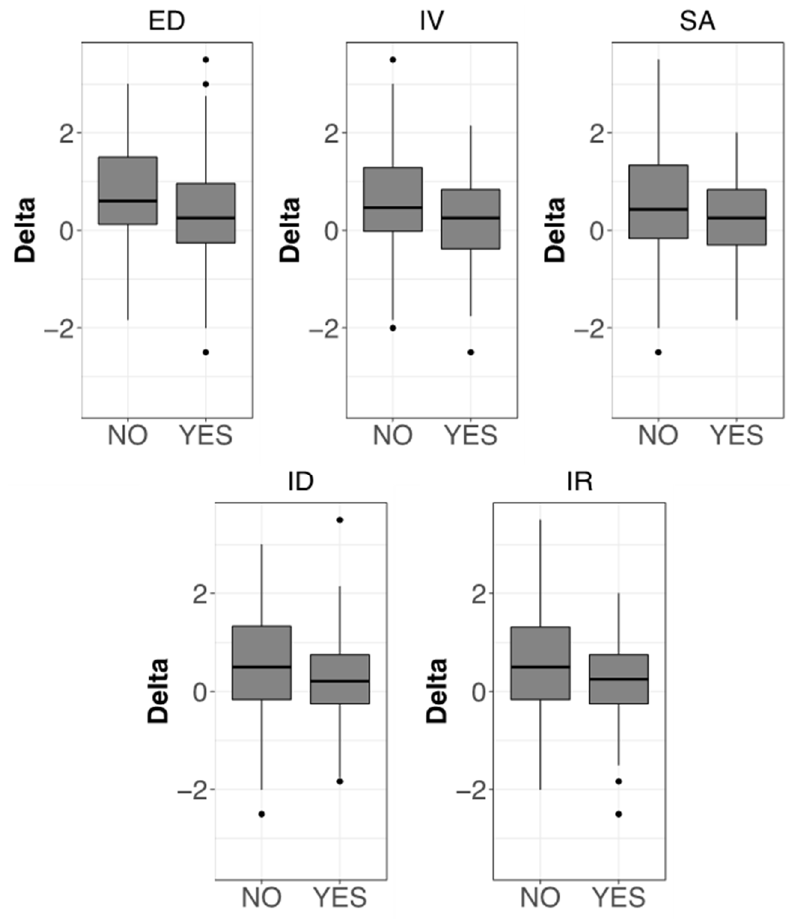
Figure 9. Boxplots showing the correlation between therapy effectiveness and different CBA ‐ H test categories. For each category of the CBA ‐ H test, two groups have been identified based on the cutoff for the presence of the related clinical concern (see Figure 6). Delta values (vertical axis) represent differences between the average efficacies of non ‐ pharmacological and pharmacological therapies. Positive values indicate the prevalence of non ‐ pharmacological treatments. Only the categories with significant differences between NO and YES cases are shown (Mann–Whitney test, p < 0.05). CBA ‐ H part B (left top): ED = Depressive mood. CBA ‐ H part C: IV = Introversion; SA = Social anxiety; ID = Interpersonal difficulties; IR = Inability to relax.